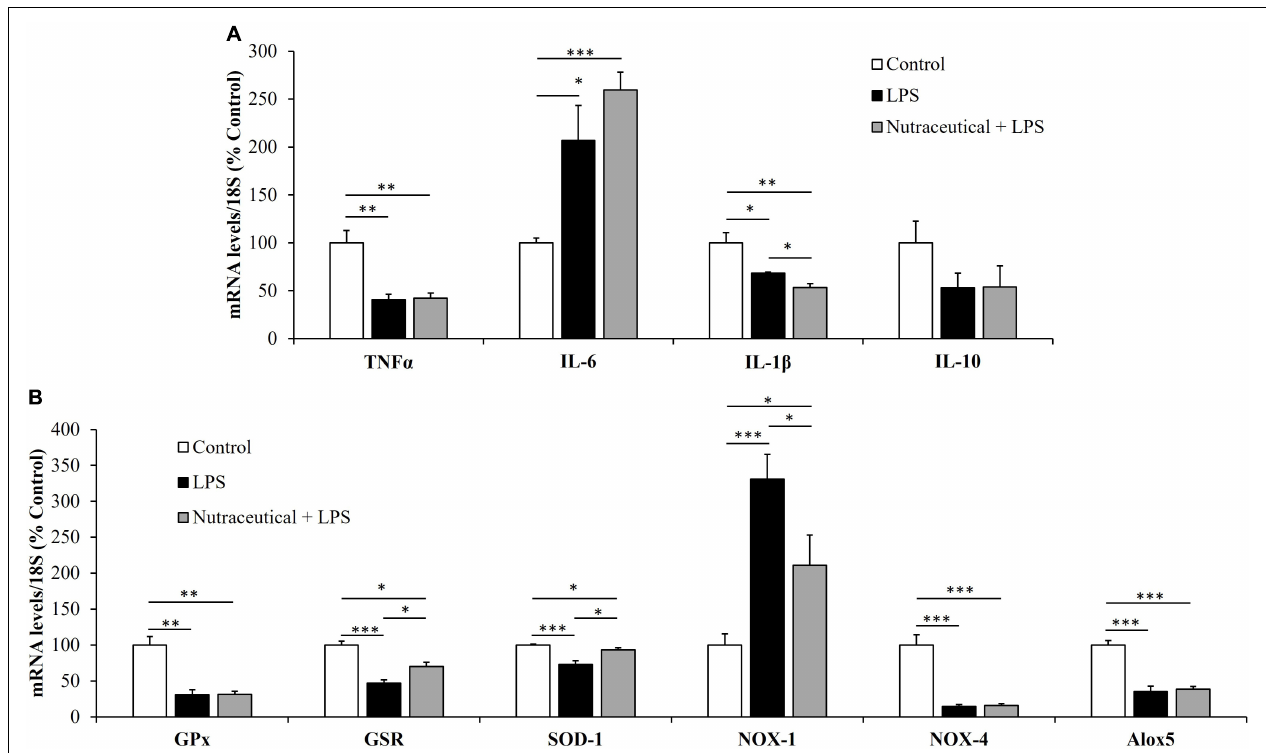
FIGURE 2 | mRNA concentrations of tumor necrosis factor α , Interleukin 6, Interleukin 1 β and Interleukin 10 (A) and glutathione peroxidase, glutathione reductase, super oxide dismutase 1, NADPH oxidase 1 and 4, and Lipoxygenase (B) in the heart of rats treated with vehicle, LPS or LPS + Nutraceutical. Values are represented as mean ± SEM. ∗ p < 0.05; ∗∗ p < 0.01; ∗∗∗ p < 0.001.